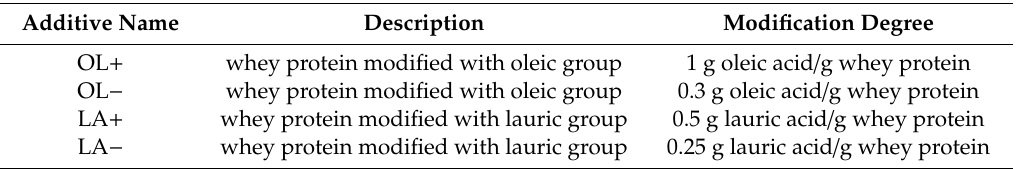
Table 5. Additives obtained by Schotten–Baumann